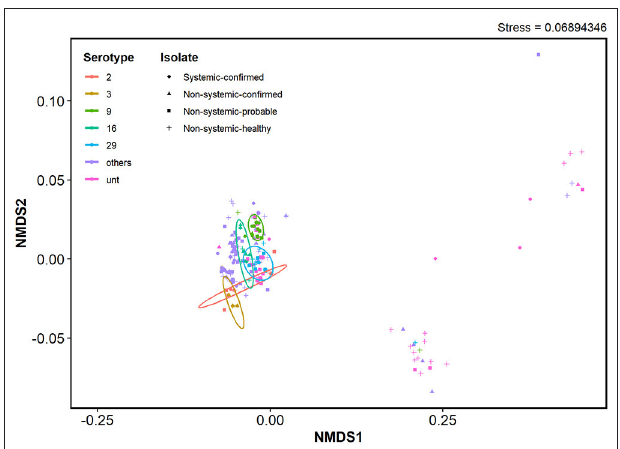
FIGURE 4 | NMDS clustering based on virulence-associated factor gene presence and absence profiles of S. suis isolates. Ordination was based on a Jaccard distance matrix generated using VAF gene presence and absence data. Ellipses represent clusters within a 95% confidence level for each isolate group. Serotypes with prevalence below 5% were grouped together as